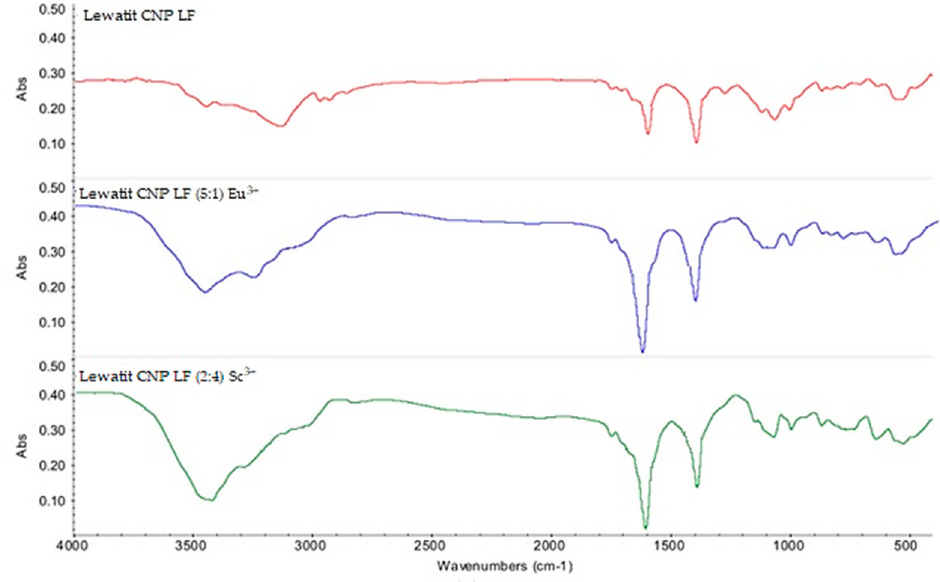
Figure 9. FTIR spectra: initial Lewatit CNP LF; Lewatit CNP LF (5:1) (with sorbed Eu 3+ ) as part of the interpolymer system; Lewatit CNP LF (2:4) (with sorbed Sc 3+ ) as part of the interpolymer system.